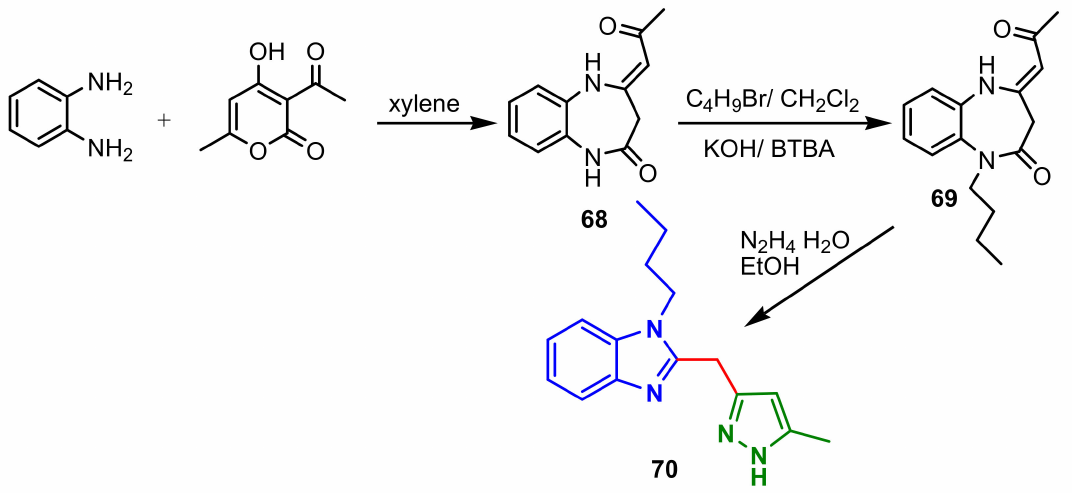
Scheme 18. Synthesis of benzimidazole–pyrazole 70 .